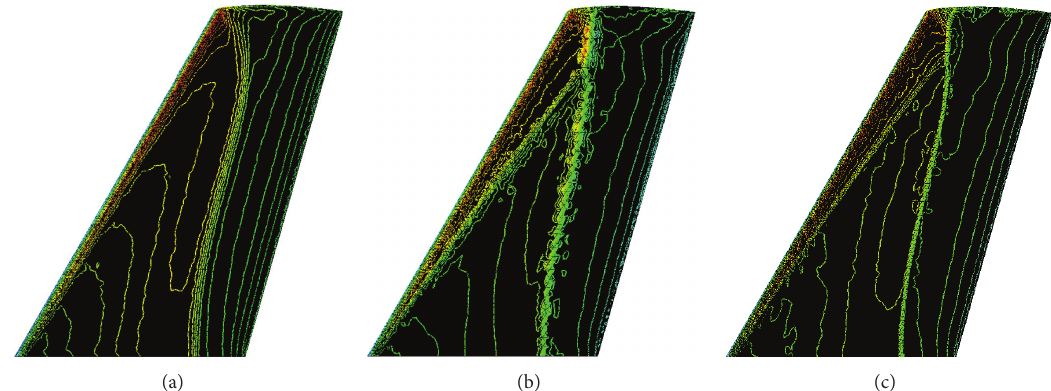
F 10: ONERA M6 wing. From le� to right, Mach number contours for: a �rst-order solution and a second-order solution on the nonadapted grid, and a second-order solution on the adapted grid.